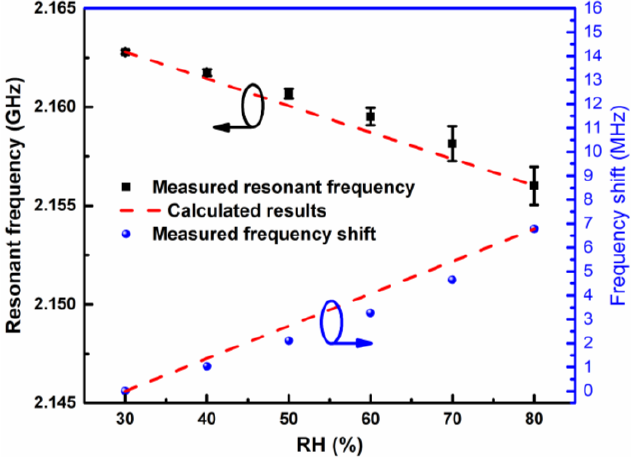
Figure 8. Measured resonant frequency of the designed sensor as a function of RH level.